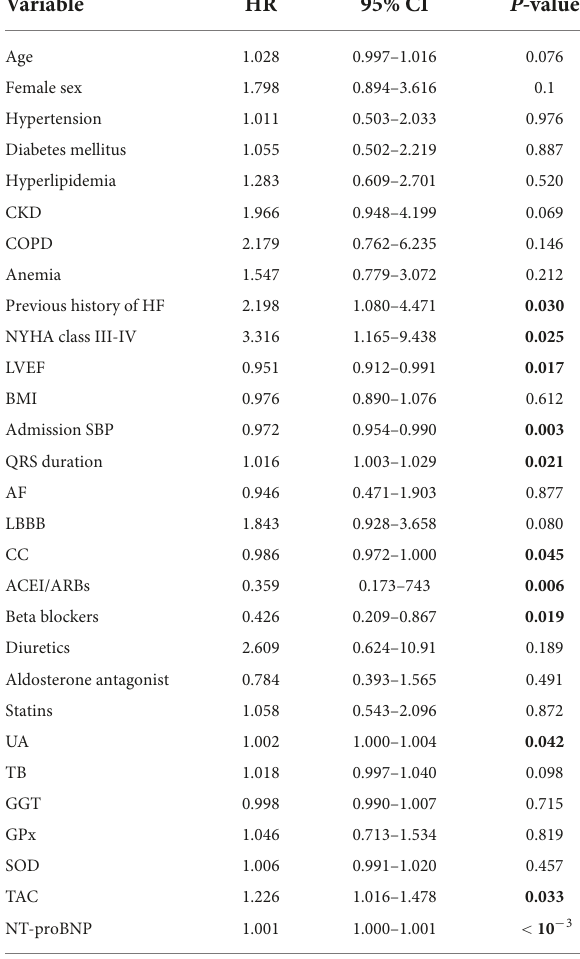
TABLE 2 Univariate Cox proportional hazards regression analysis for predictors of post-discharge